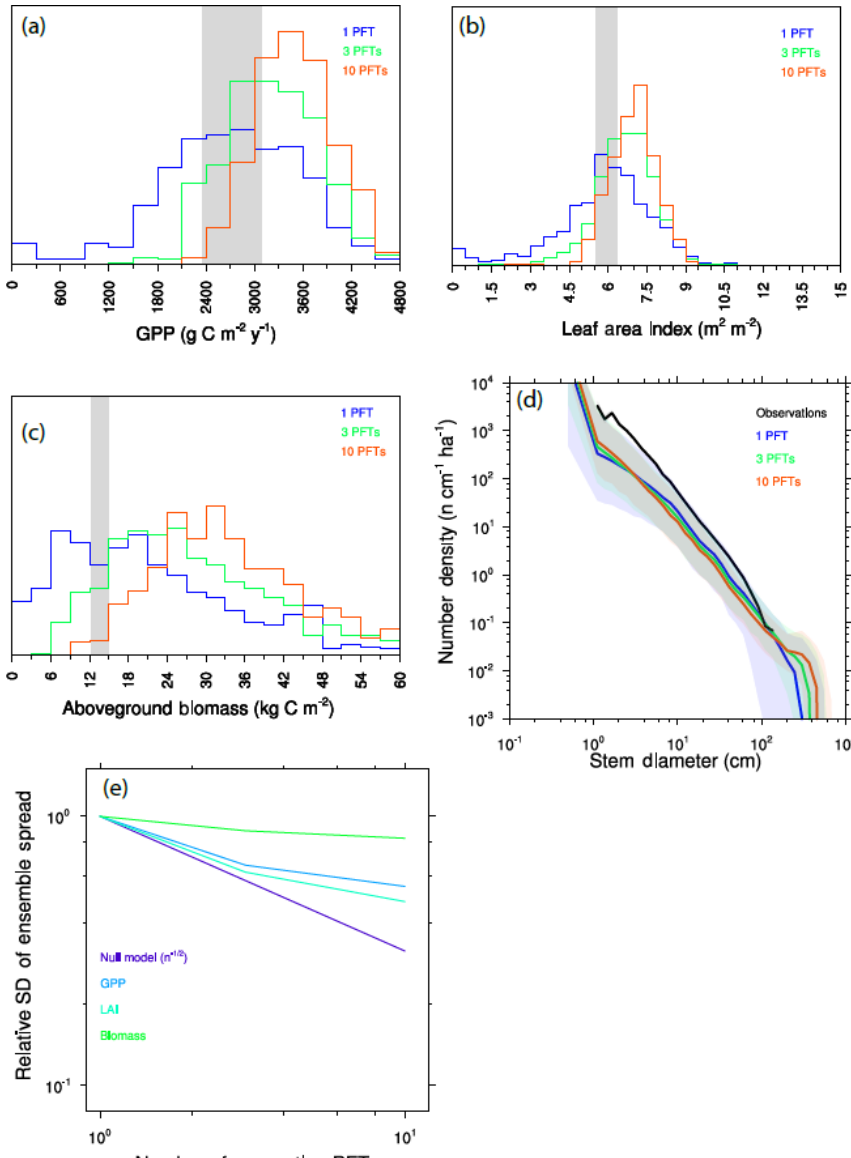
Figure 10. Variation between ensemble members as a function of the number of competing PFTs in each ensemble member. (a–c) Histograms of mean GPP (a) , LAI (b) , and aboveground biomass (c) . Observational range shown as grey band in (a) – (c) . (d) Size distributions of ensembles. (e) Standard deviation across ensemble members as a function of the number of competing PFTs, as compared to a null model, which considers the distribution changes purely to be a sampling problem, for expected reduction in variation between ensemble members in the absence of competition